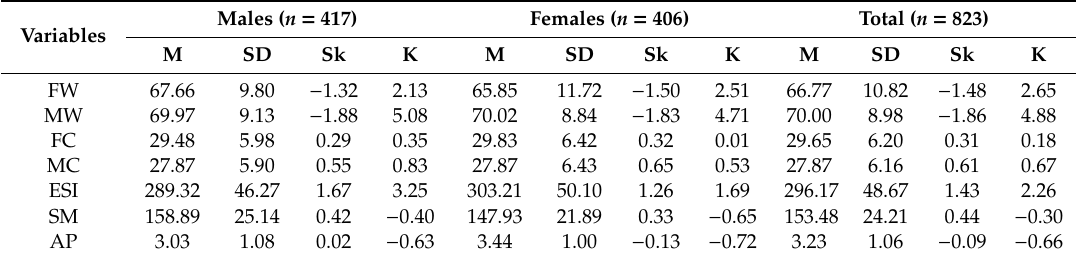
Table 1. Descriptive statistics of study variables for males, females, and total sample. Variables